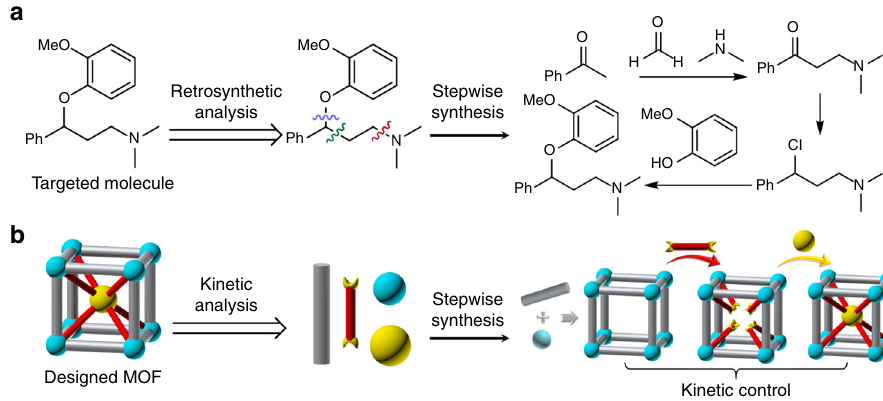
Fig. 1 Schematic representations. Retrosynthesis of organic molecules ( a ) and multi-component MOFs ( b